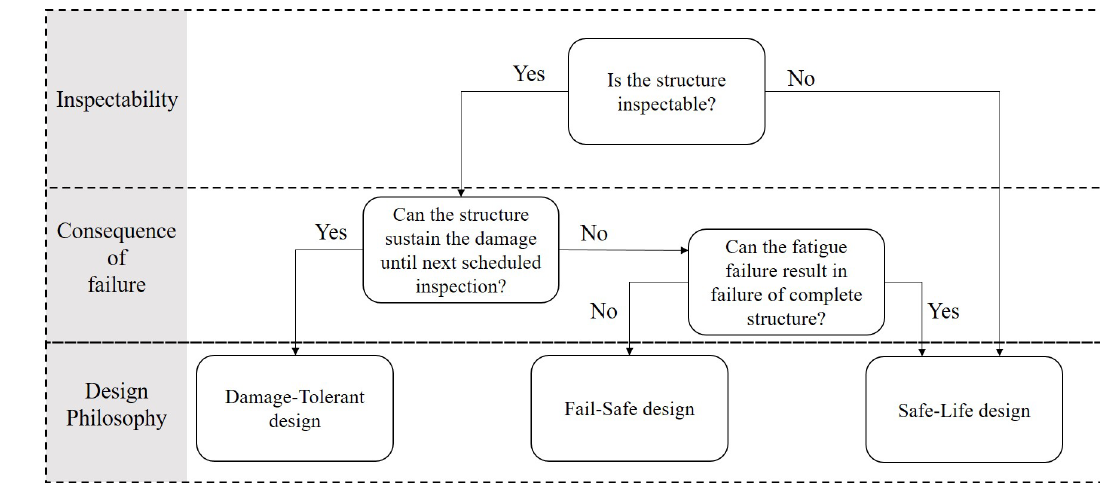
Figure 1. Relationship between inspection and fatigue design